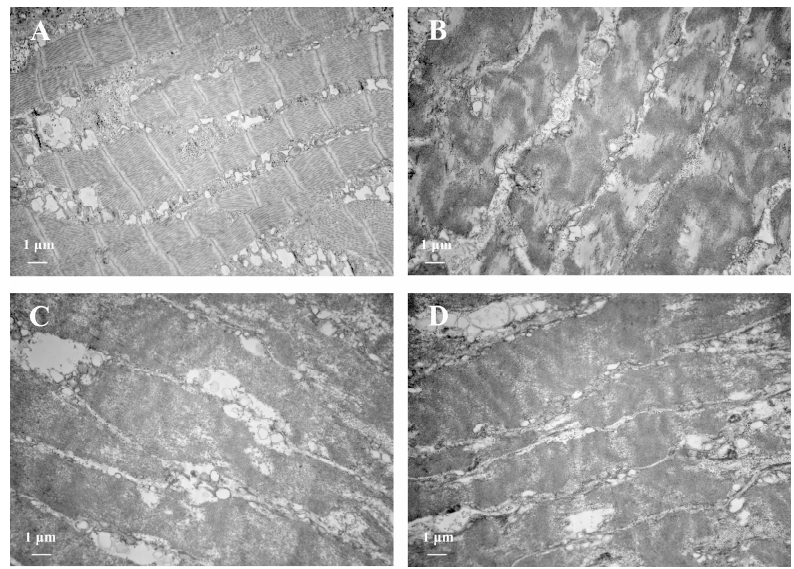
Figure 4. Transmission electron microscopy of myofibrils from SAMs after boiling at 12,000× field of view. ( A ) Fresh sample; ( B ) 30-s-boiled sample; ( C ) 3-min-boiled sample; ( D ) 15-min-boiled sample.